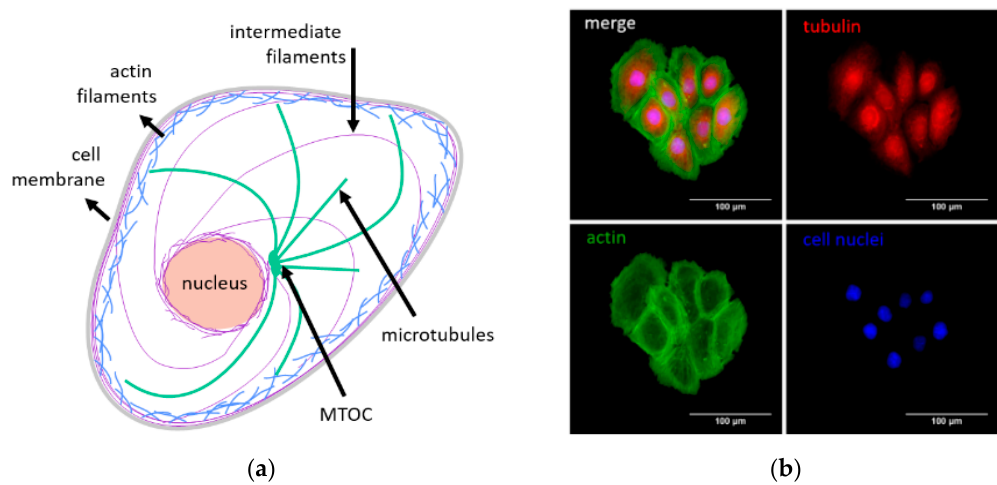
Figure 2. ( a ) A scheme showing the organization of three main cytoskeletal elements (actin and intermediate filaments, microtubules) inside the cell in relation to the cell membrane and nucleus (MTOC–a microtubule-organizing center). ( b) Exemplary fluorescent images were collected for DU145 prostate cancer cells showing labeled actin filaments and